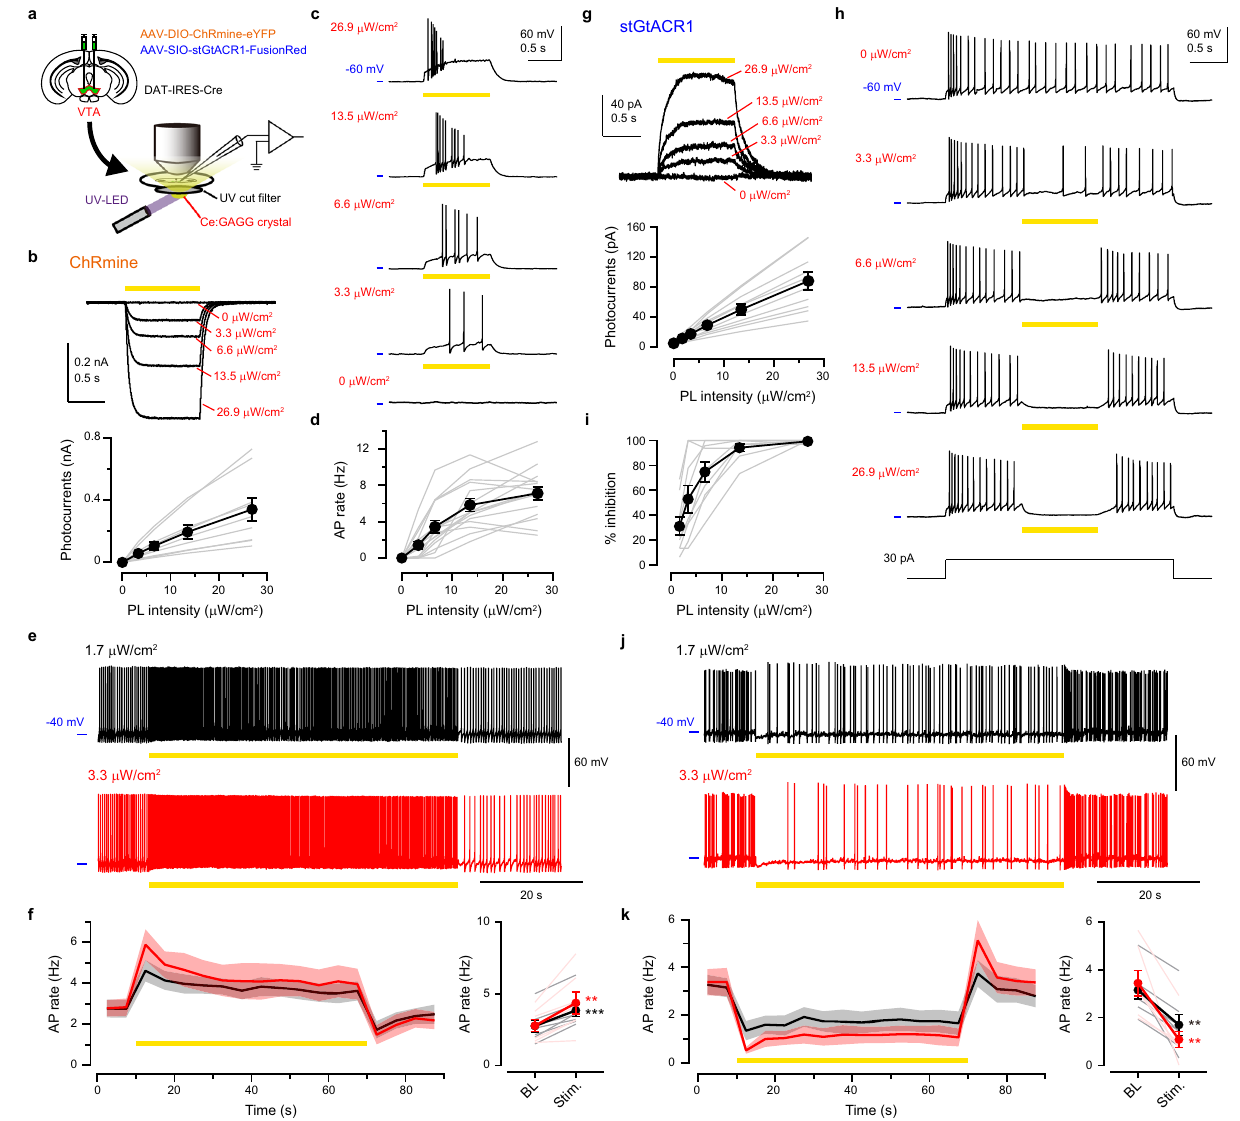
Fig. 2 Photo-luminescence of Ce:GAGG bidirectionally actuated VTA-DA neurons in vitro. a Schematic of the experiment. b Top, sample voltage-clamp recordings from a ChRmine-expressing VTA-DA neuron responding to 1-s Ce:GAGG PL. Bottom, photocurrent amplitude vs. PL intensity ( n = 9 cells). c Sample recordings from a ChRmine-expressing VTA-DA neuron current-clamped at approximately − 60 mV, responding to 1-s PL. d AP rate of ChRmine- expressing neurons vs. PL intensity ( n = 15 cells). e Sample recordings from a ChRmine-expressing neuron current-clamped at approximately − 40 mV, responding to 1-min PL illumination. f Time course (left) and quanti fi cation (right) of average AP rates with 1-min PL illumination at 1.7 (black) or 3.3 (red) μ W/cm 2 . Thick line: mean, Shadows: ± SEM, BL: baseline, Stim.: stimulation. 1.7 μ W/cm 2 : n = 7 cells, *** p = 0.0002; 3.3 μ W/cm 2 : n = 10 cells, ** p = 0.0017; paired t -test, two-sided. g Same as b , but from stGtACR1-expressing VTA-DA neurons ( n = 11 cells). h Same as c , but for a stGtACR1-expressing neuron. APs were evoked by the current injection. i Success rate of spike suppression by Ce:GAGG PL in stGtACR1-expressing neurons ( n = 10 cells). j , k Same as e , f but for stGtACR1-expressing neurons. 1.7 μ W/cm 2 : n = 7 cells, ** p = 0.0017; 3.3 μ W/cm 2 : n = 7 cells, ** p = 0.0034; paired t -test, two-sided. Lightly colored lines indicate individual cells. Values are mean ±